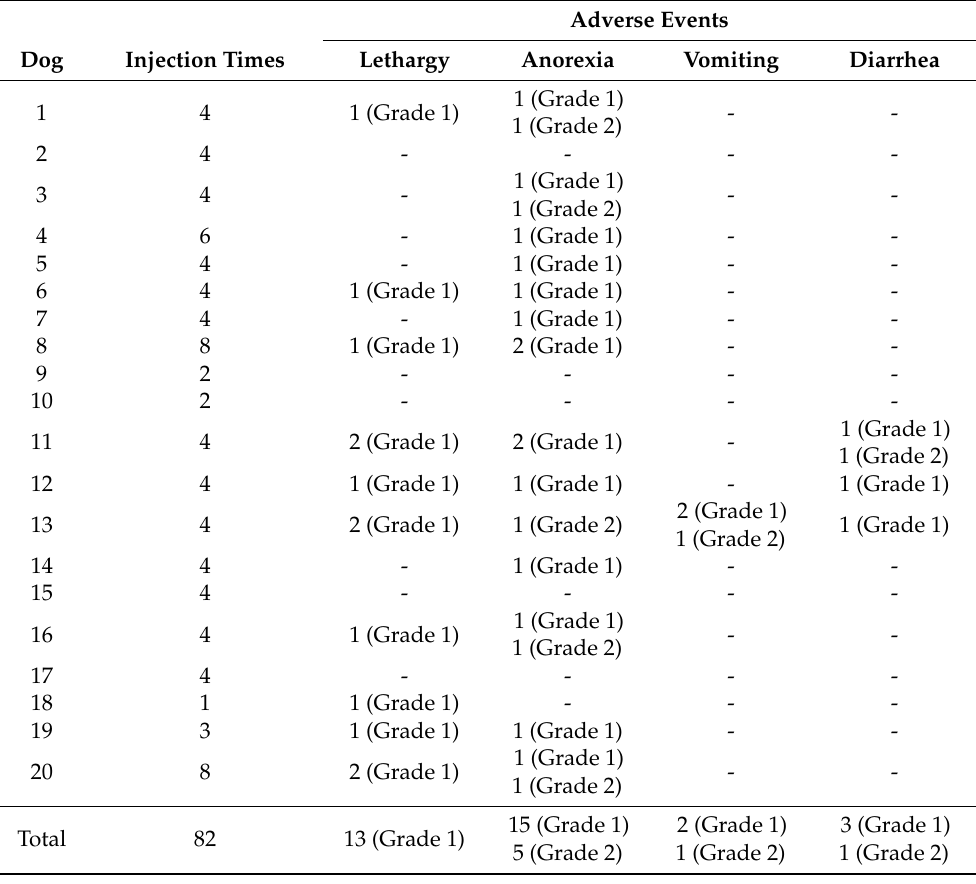
Table 2. Adverse events of l-asparaginase administration.